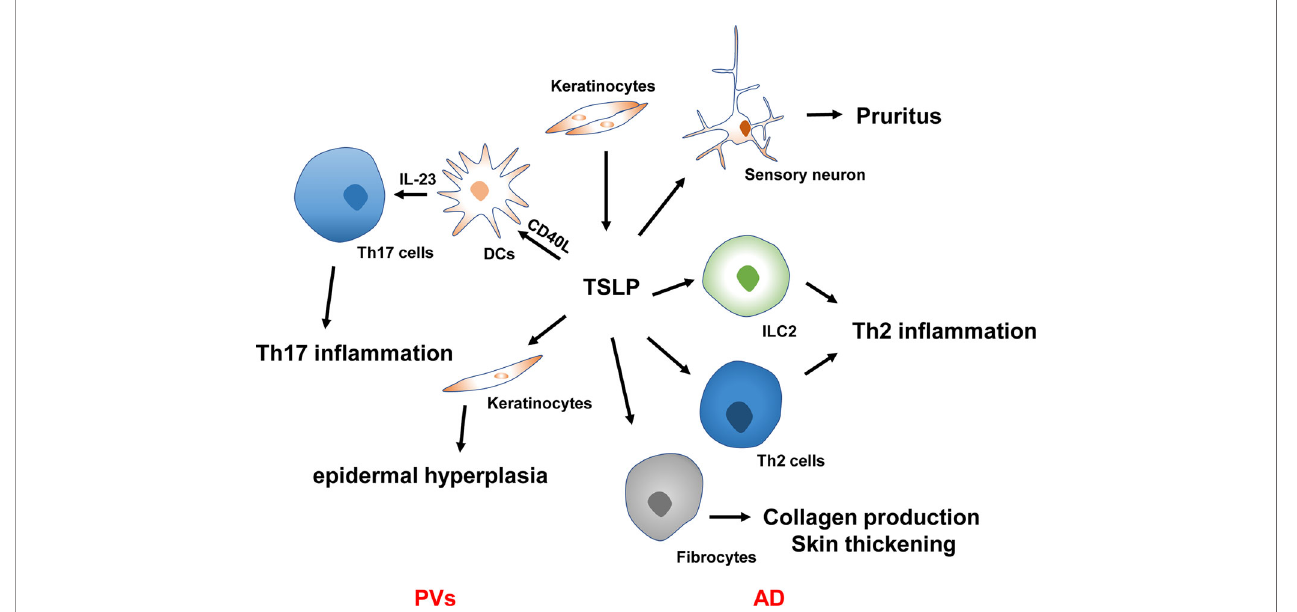
FIGURE 2 | TSLP in the pathogenesis of AD and PVs. TSLP causes Th2 in fl ammation, pruritus, collagen production, and skin thickening in the pathogenesis of AD. TSLP synergy with CD40L to promote DC activation and IL-23 production, resulting in Th17 in fl ammation in the context of PVs. TSLP also regulates keratinocyte proliferation in the plaque of PVs, leading to epidermal hyperplasia. PVs, psoriasis vulgaris; AD, atopic dermatitis; ILC2, type 2 innate lymphoid cells; Th2 cells, type 2 T helper cells; Th17 cells, type 17 T helper cells; IL,